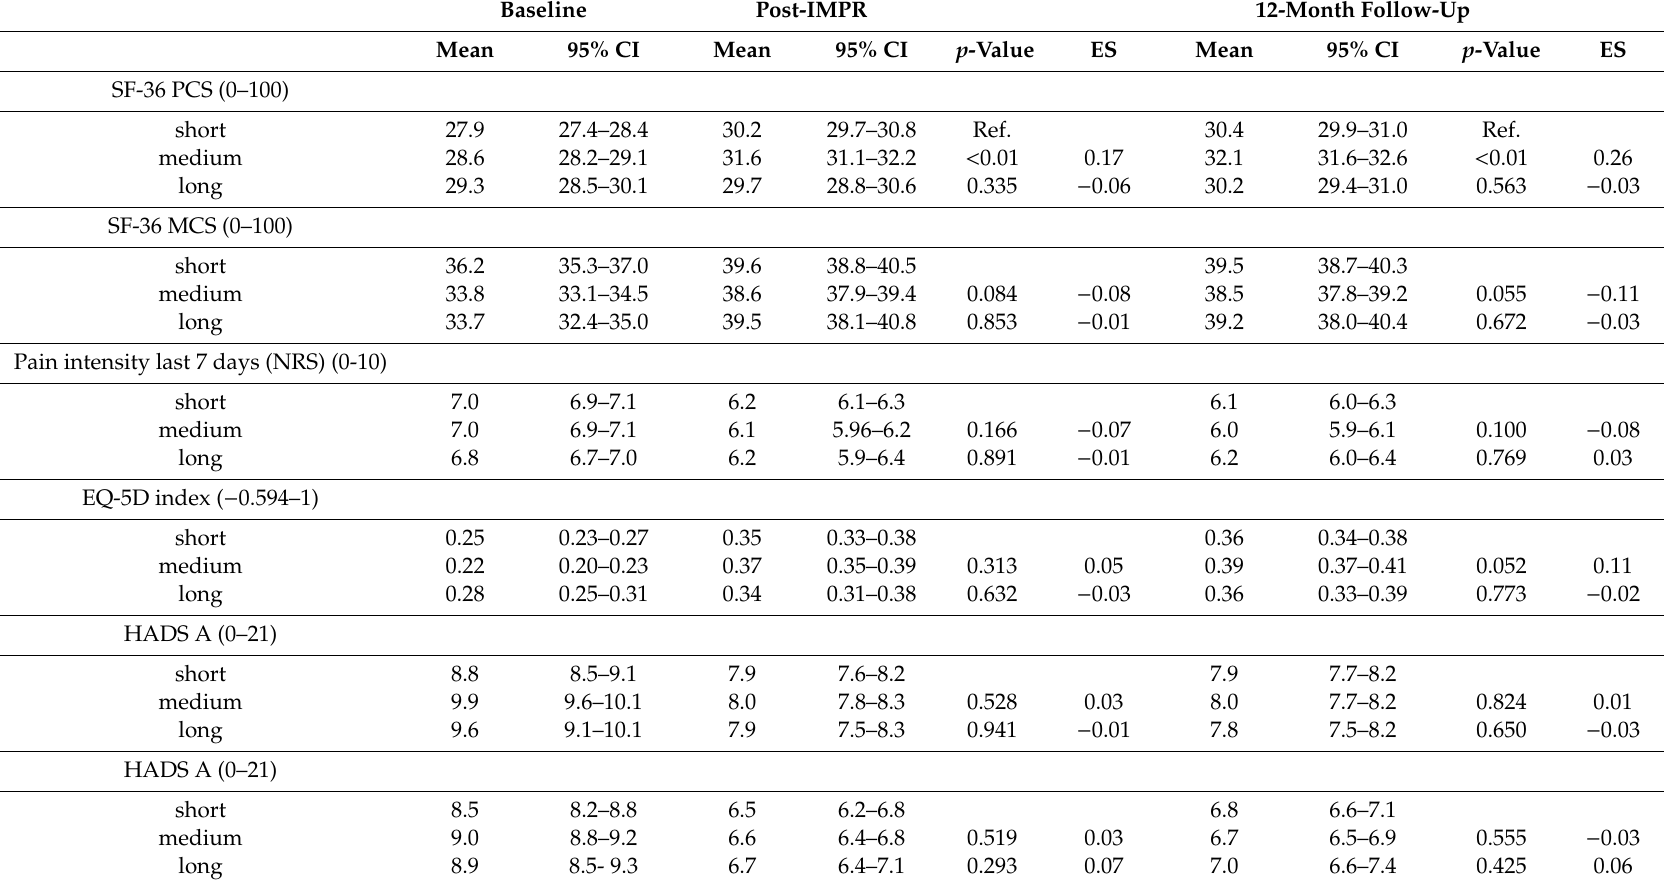
Table 3. Between-group results at baseline and after completion of IMPR program, and at 12-month follow-up. Marginal e ff ects and p-values from pairwise comparisons with reference (short duration) are